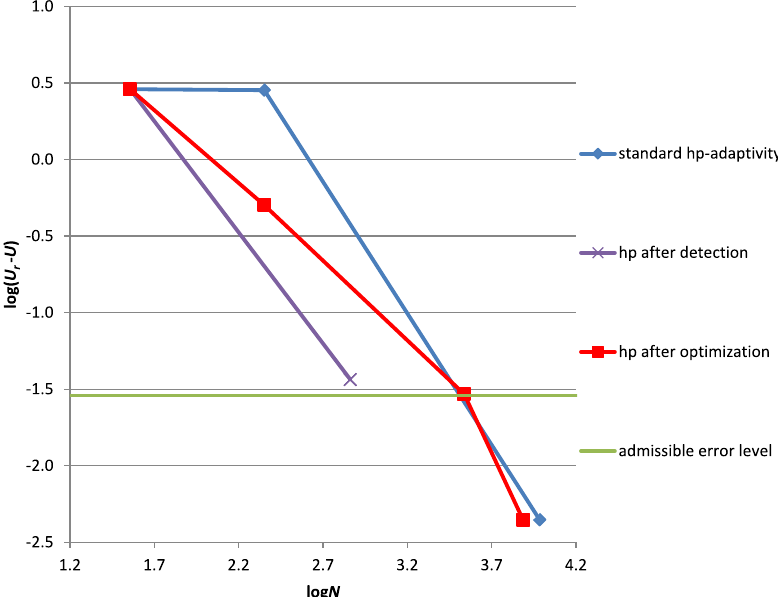
Figure 14. A quarter of a bending-dominated plate—convergence for three adaptation